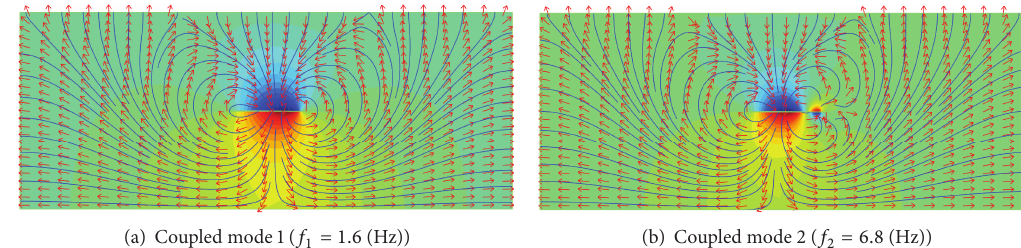
Figure 4: The colors pertain to the pressure field and the arrows to the velocity field in the case of 90 ∘ /0 ∘ /90 ∘ /0 ∘ /90 ∘